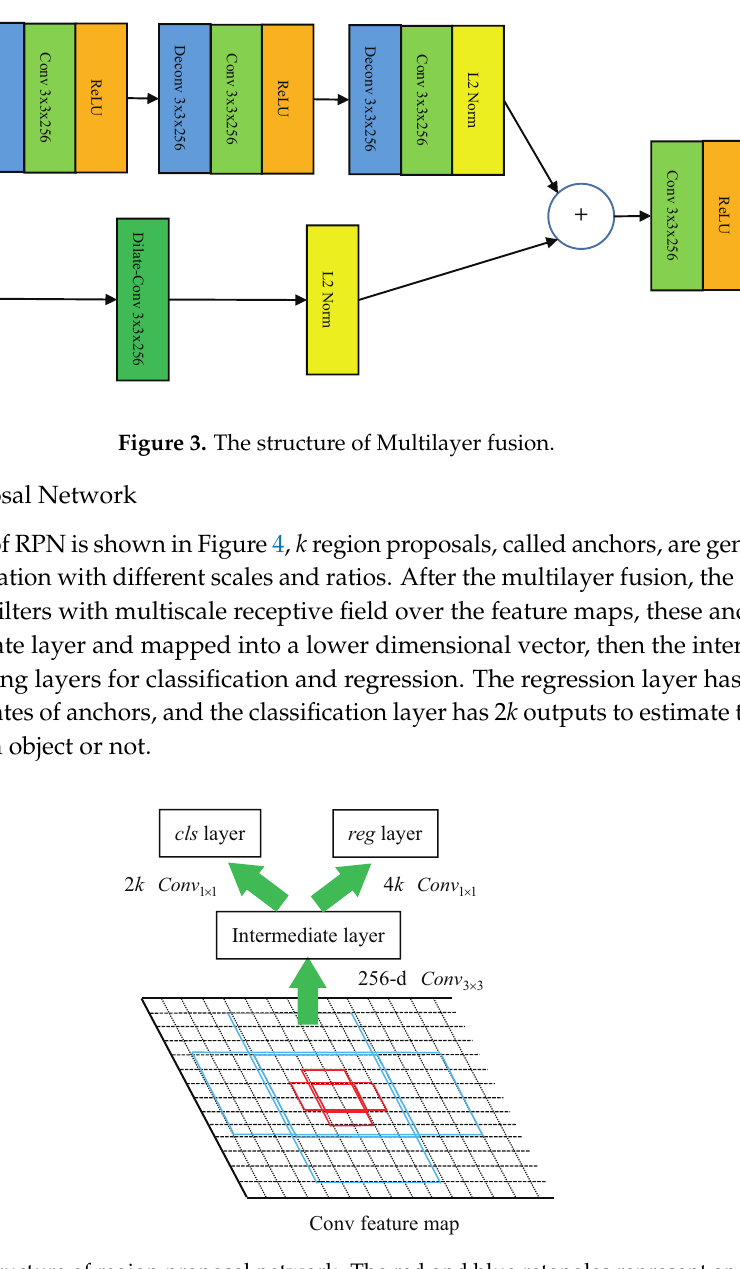
Figure 4. The structure of region proposal network. The red and blue retangles represent anchors with different scales and